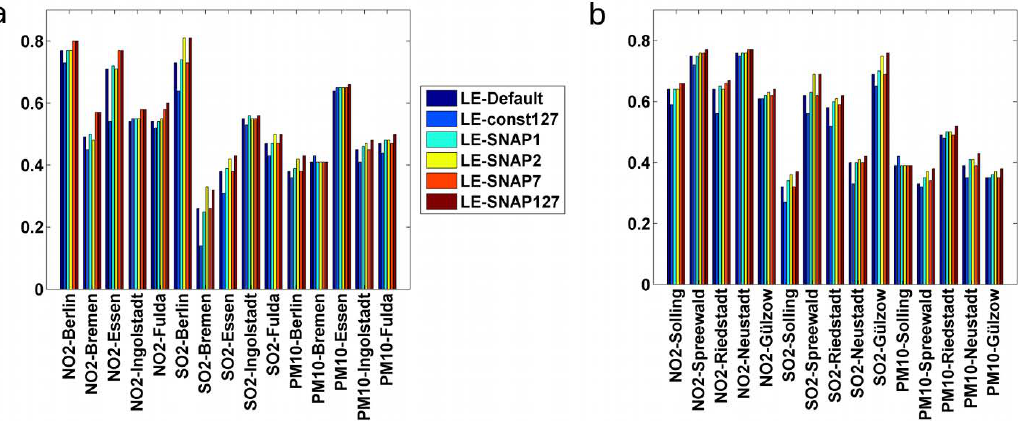
Fig. 5. Bar charts of the daily correlation coefficients for all simulations at selected urban (a) and rural (b) background stations across